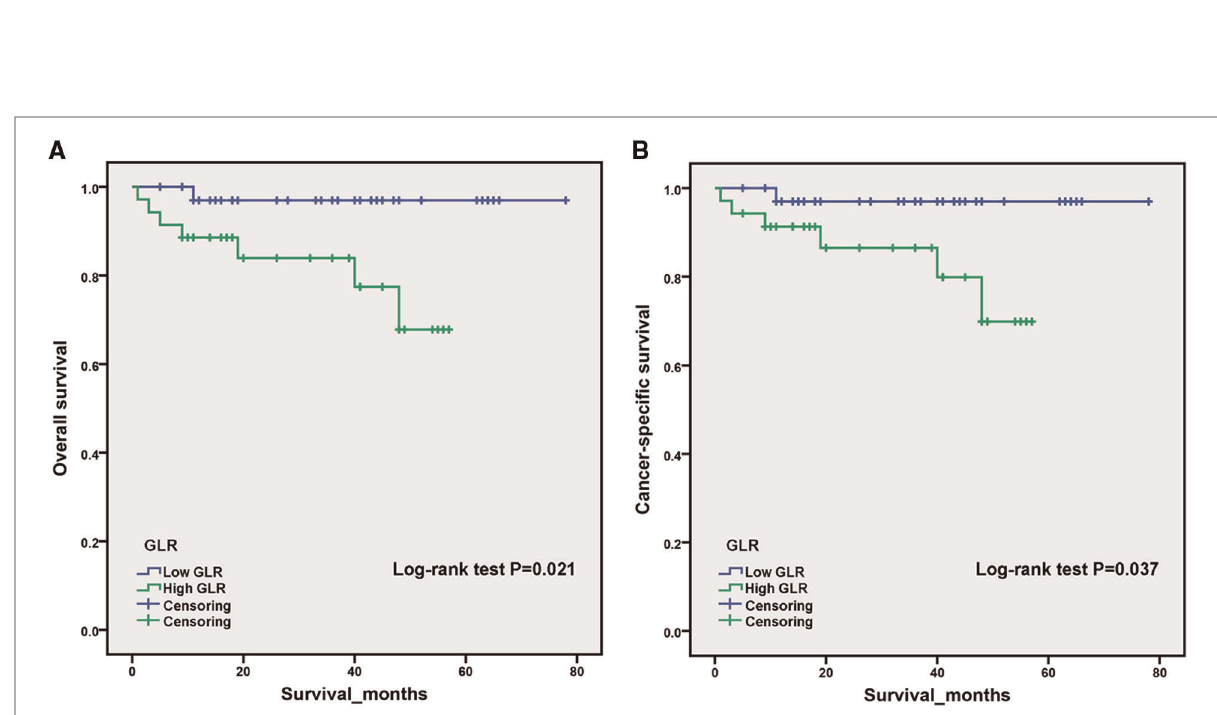
FIGURE 3 After propensity score matching, Kaplan – Meier curves for overall survival ( A ) and cancer-speci fi c survival ( B ) in patients strati fi ed according to glucose to lymphocyte